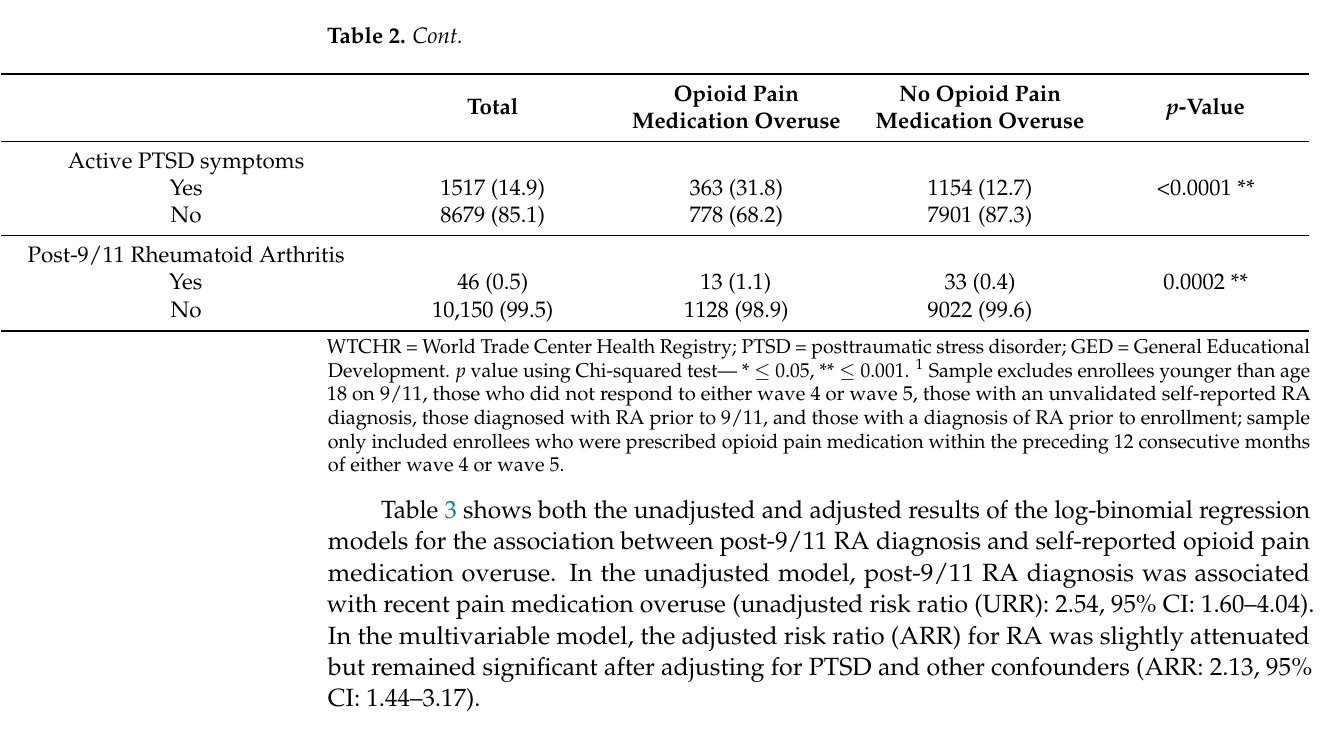
Table 3. Unadjusted and adjusted relative risk (RR) and 95% confidence interval (CI) for the